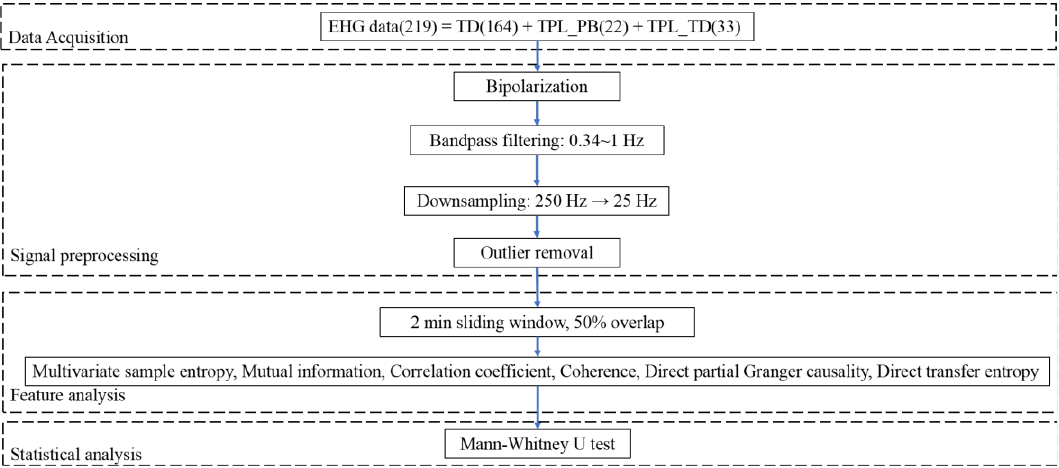
Figure 1. Flow chart of the proposed method.